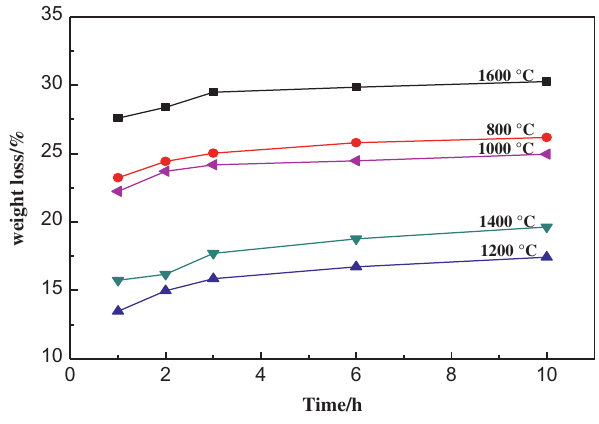
Figure 3: Oxidation weight loss curves at 1,000°C in air as a function of time for the B-Si carbon materials obtained by carbonization treatment at different